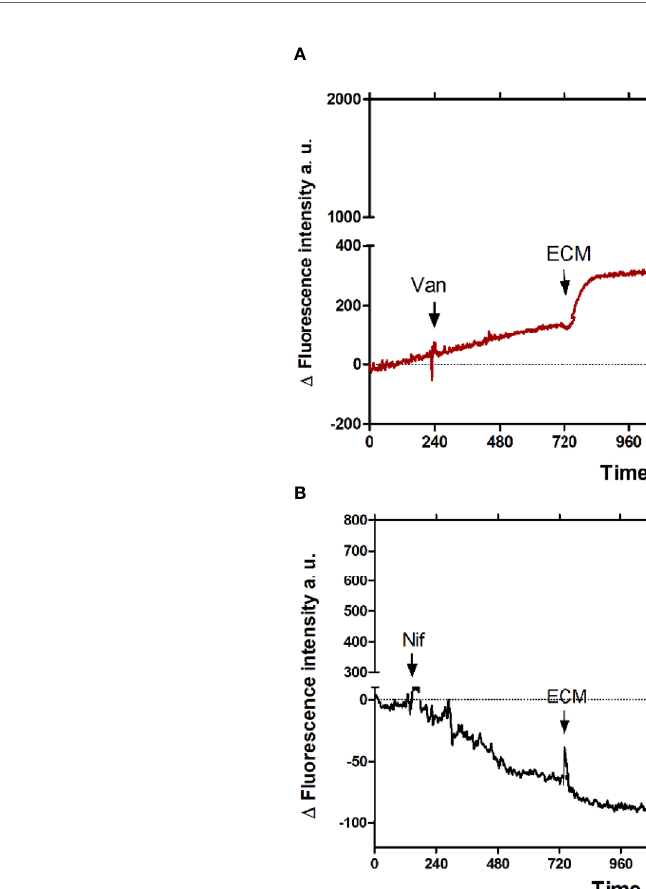
ECM and speci fi c Ca 2+ homeostasis disruptors: ( Supplementary Figure 2 ): Antimycin A (AA, 0.3 μg/mL) for mitochondria, Cyclopiazonic acid (CPA, 0.3 μM) for the endoplasmic reticulum (ER) ( Figures 4A, B ), and Ba fi lomycin A (Baf, 1 μM) for acidocalcisomes ( Figure 4C ). As shown in Figure 4B , the amount of free intracellular Ca 2+ measured after AA treatment was higher than the sample without AA, and it is also higher than the control without the ECM ( Figure 4A ). No signi fi cant modi fi cations were observed when CPA was added to trypomastigotes incubated or not with ECM